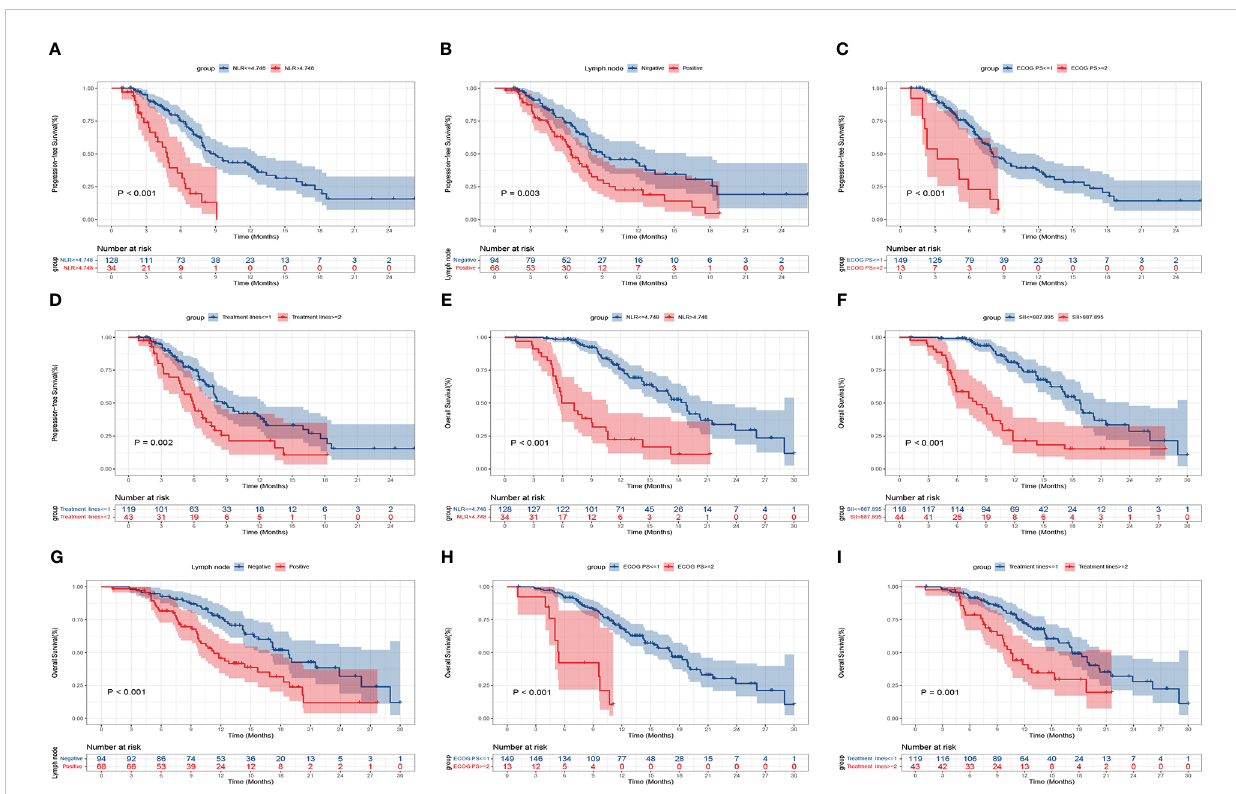
FIGURE 5 Kaplan-Meier curves of progression-free survival (PFS) and overall survival (OS) for patients with advanced or metastatic ESCC according to baseline clinical parameters. PFS: NLR (A) , lymph node metastasis (B) , ECOG PS (C) , treatment lines (D) ; OS: NLR (E) , SII (F) , lymph node metastasis (G) , ECOG PS (H) , and treatment lines (I)